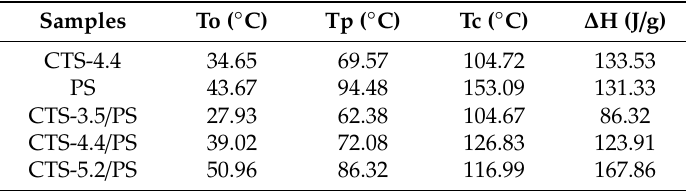
Table 9. The glass transition temperature and enthalpy of samples.